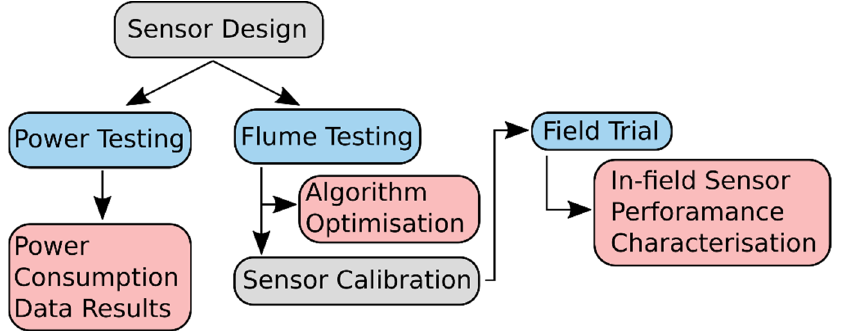
Figure 1. Flowchart describing the design, validation, and characterisation procedures used in this study; major experiments are in blue, and outcomes are in red.